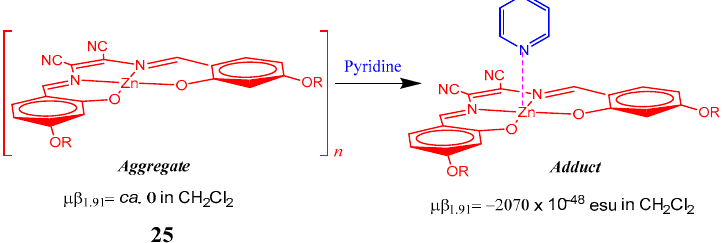
Figure 4. Switching on the second-order NLO response for complex 25 by the addition of pyridine. Reproduced from Ref. [63] with permission from The Royal Society of Chemistry.